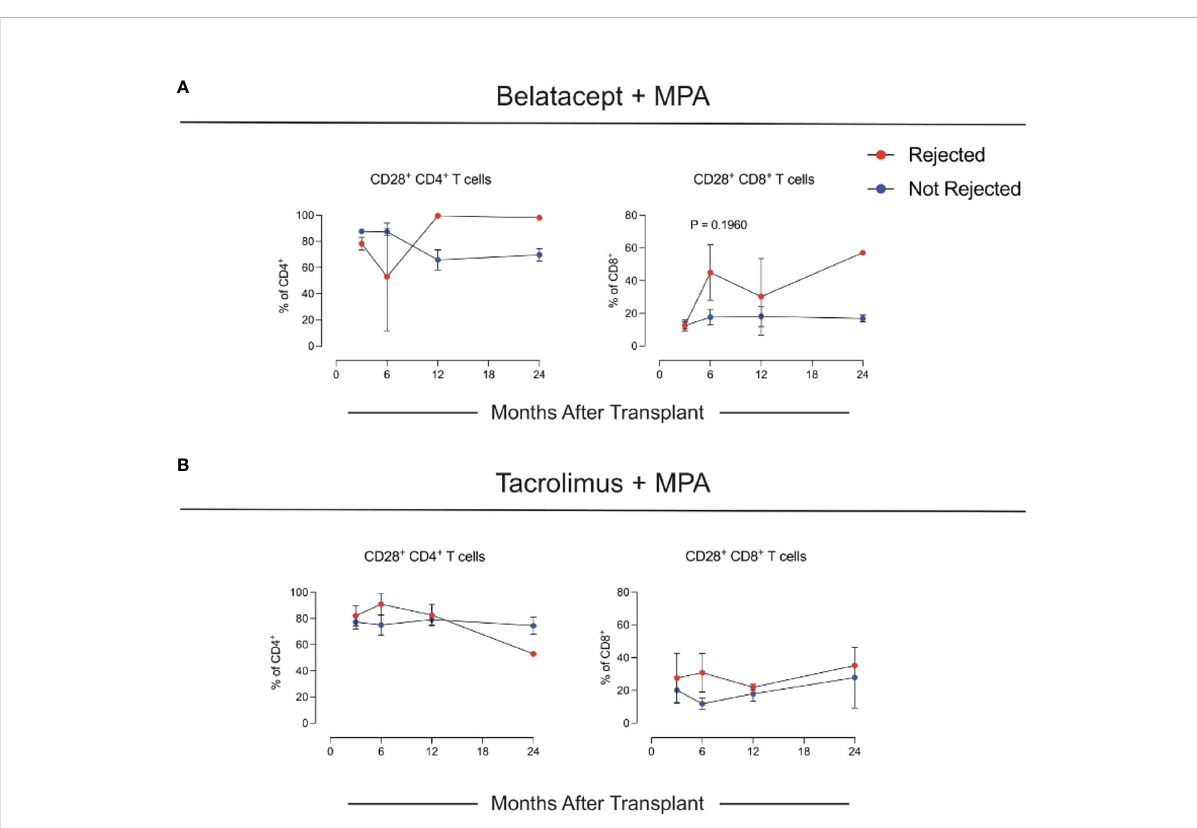
FIGURE 4 Changes in CD28 + T cells. (A) Changes in CD28+ CD4+ and CD8+ T cells in the Belatacept + MPA and (B) in the Tacrolimus + MPA